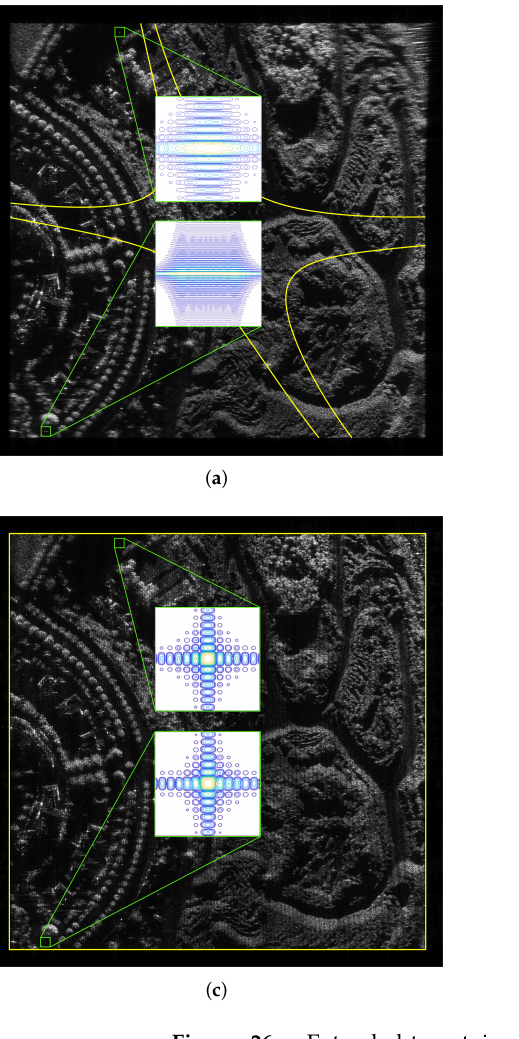
Figure 26. Extended-target images processed by ( a ) zero-layer ML-OSA (traditional PFA), ( b ) one-layer ML-OSA, ( c ) two-layer ML-OSA and ( d ) BPA with the continuously time-varying radar